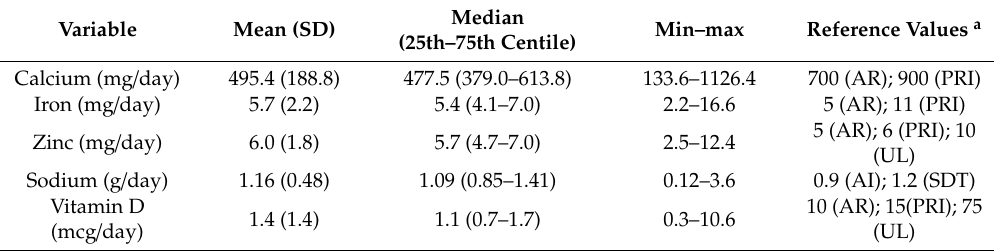
Table 10. Daily dietary intake of minerals and vitamin D in children aged 4 ≤ years < 7 ( n = 134) †